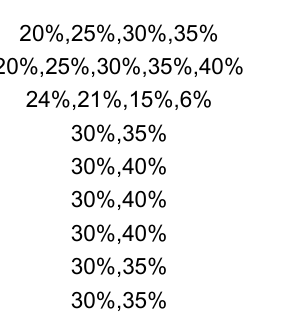
Selected Publications on the Isolation of Lipid Rafts in OptiPrep  Gradients Iodixanol gradient Centrifugation Source material Ref #